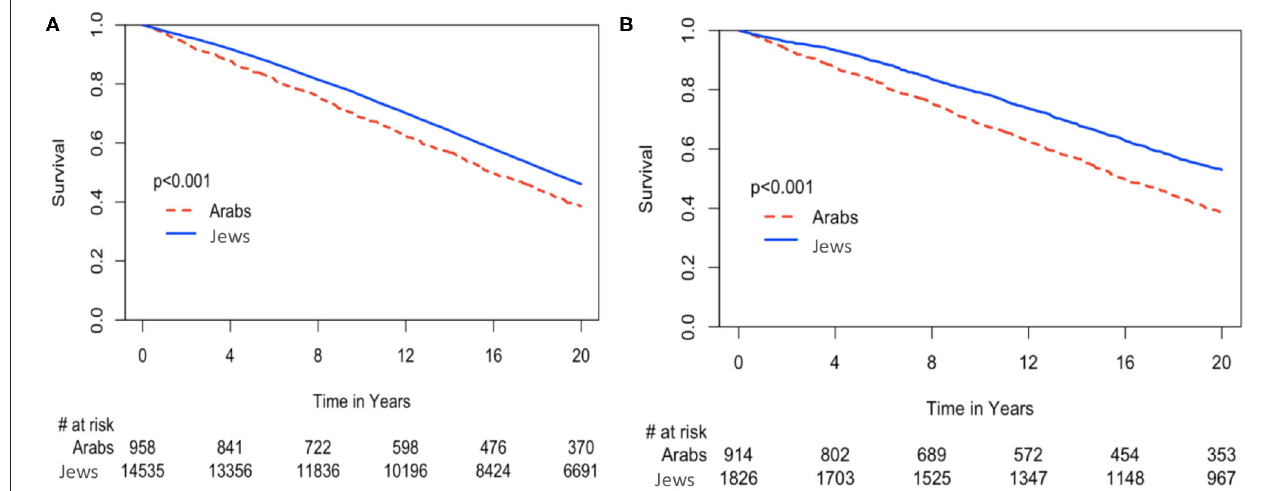
FIGURE 2 | (A) Kaplan-Meier of 20-year survival estimates for the entire cohort according to ethnicity. (B) Kaplan-Meier of 20-year survival estimates for the propensity score matched cohort according to ethnicity.